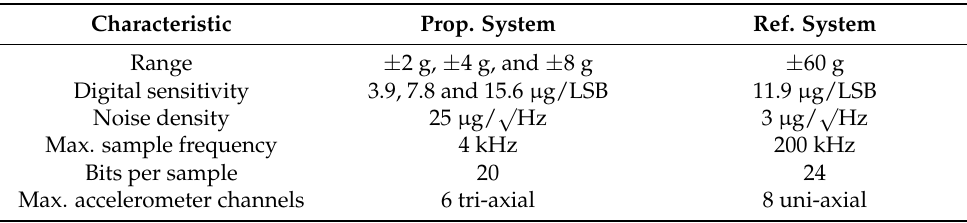
Table 1. Main characteristics of the proposed and reference system. Characteristic Prop. System Ref. System